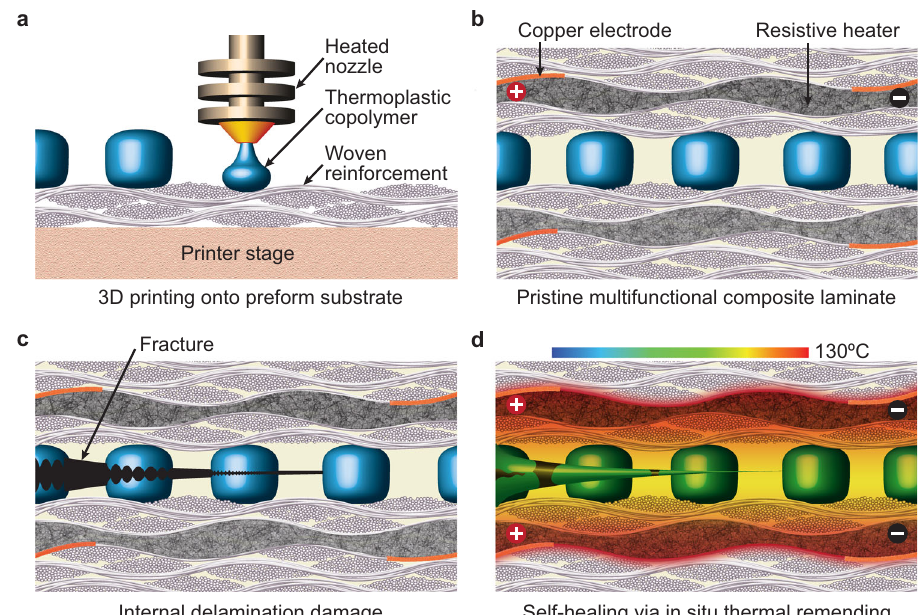
Fig. 1 | Overview concept of self-healing via in situ thermal remending. a 3D printed micro-domains of polyethylene-co-methacrylic acid (EMAA) directly onto woven fi ber-reinforcement. b Fiber-compositelaminateconstructedbyinfusionof the epoxy matrix into a symmetrically-stacked textile preform containing EMAA- modi fi ed reinforcement and resistive heater interlayers. c Upon interlaminar delamination in the composite, cohesive fracture ruptures EMAA as opposed to adhesive separation from composite — due to strong interfacial bonding